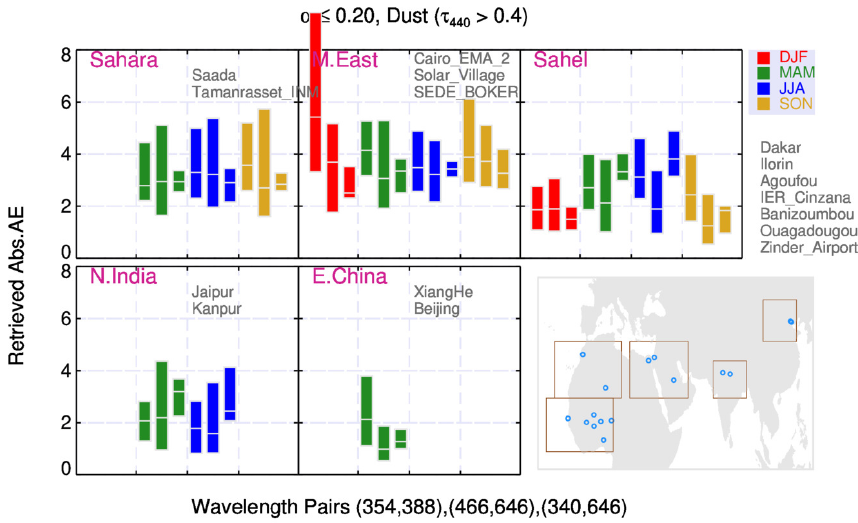
Figure 16. Absorption Ångström exponent derived at three wavelength pairs for observations with τ 440 > 0 . 4 for the coarse-mode dust aerosols. Boxplot represents the lower and upper quartile of observations with the mean as the white